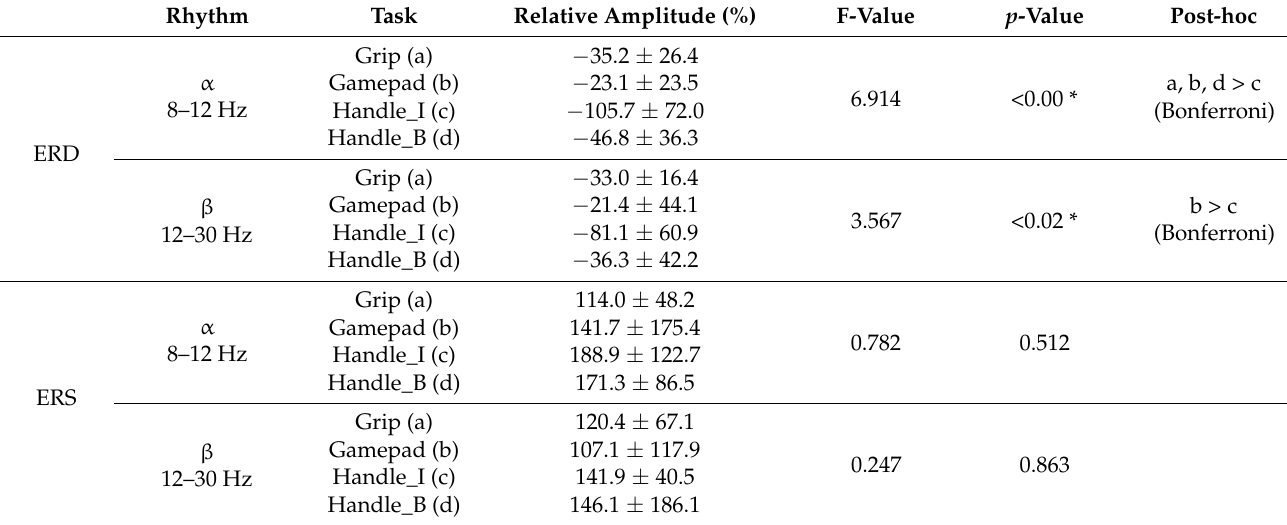
Table 2. Two-way ANOVA and post-hoc analysis (data shown as the mean ± SD, * p <